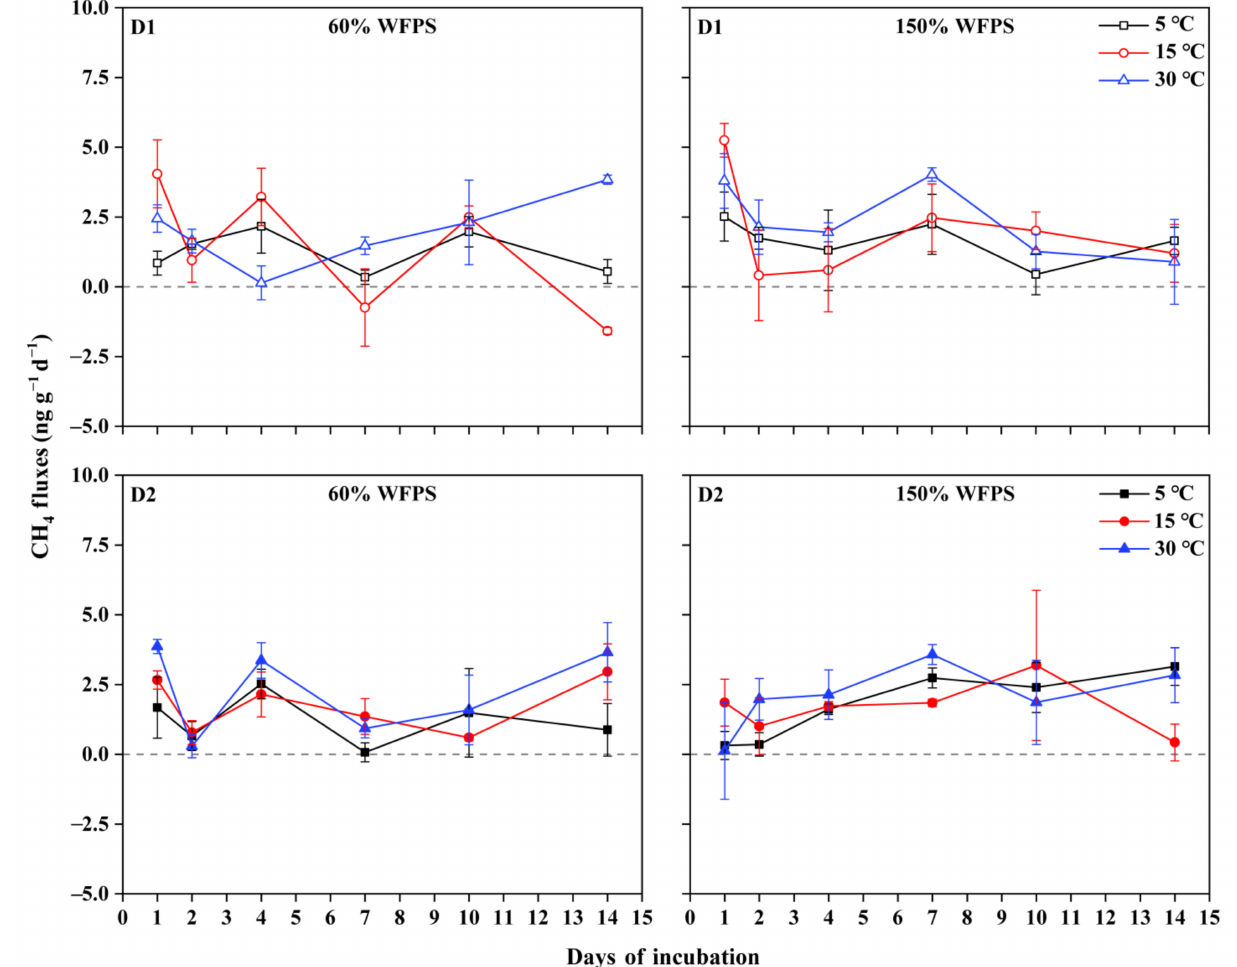
Figure 2. CH 4 fluxes (ng g − 1 d − 1 ) of the different treatment samples during the incubation period. Positive values indicate CH 4 emission, and negative values indicate CH 4 uptake. The incubation treatments comprised of combinations of three temperatures (5, 15, and 30 ◦ C) and two soil moisture states (60% and 150% WFPS) applied to soils from two depths (D1: surface soil from 0–20 cm and D2: subsurface soil from 20–50 cm). WFPS: water-filled pore